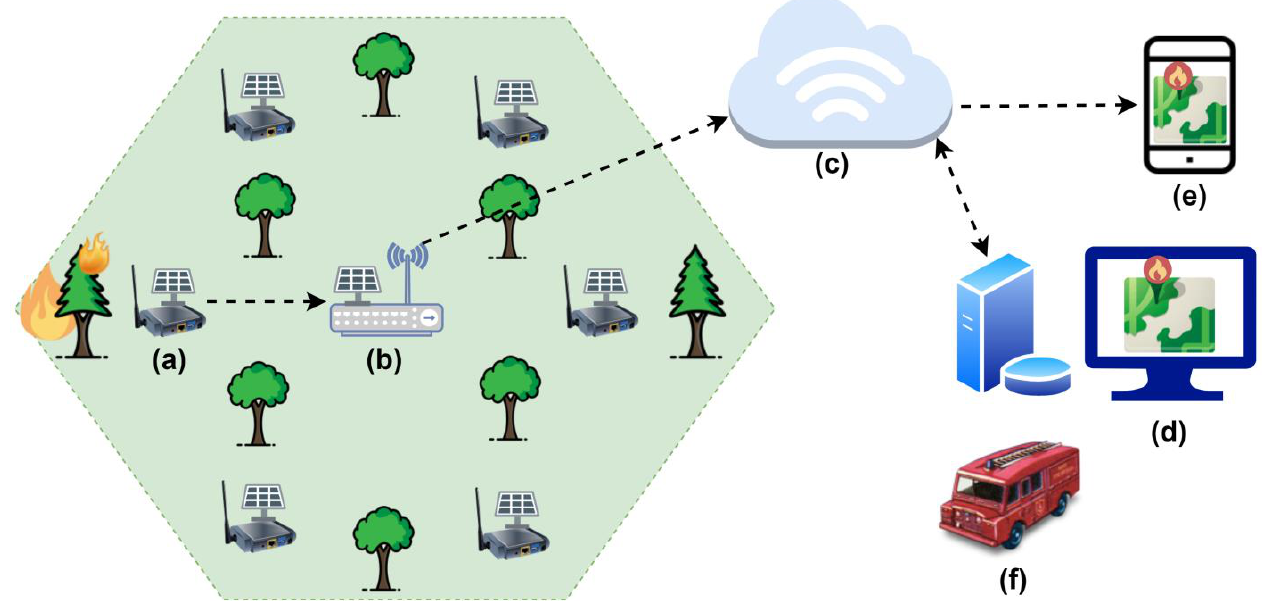
Figure 1. Sensor node ( a ) detects fire and sends the data wirelessly to the hub ( b ) using a long-range (LoRa) transmitter. The hub sends the data to the central server using the cellular Internet ( c ). The server marks the location on a map ( d ) and also sends notifications to the smartphone apps ( e ) of the firefighters. Then, a fire truck ( f ) is dispatched. Sensor nodes and the hub are powered by solar panels.